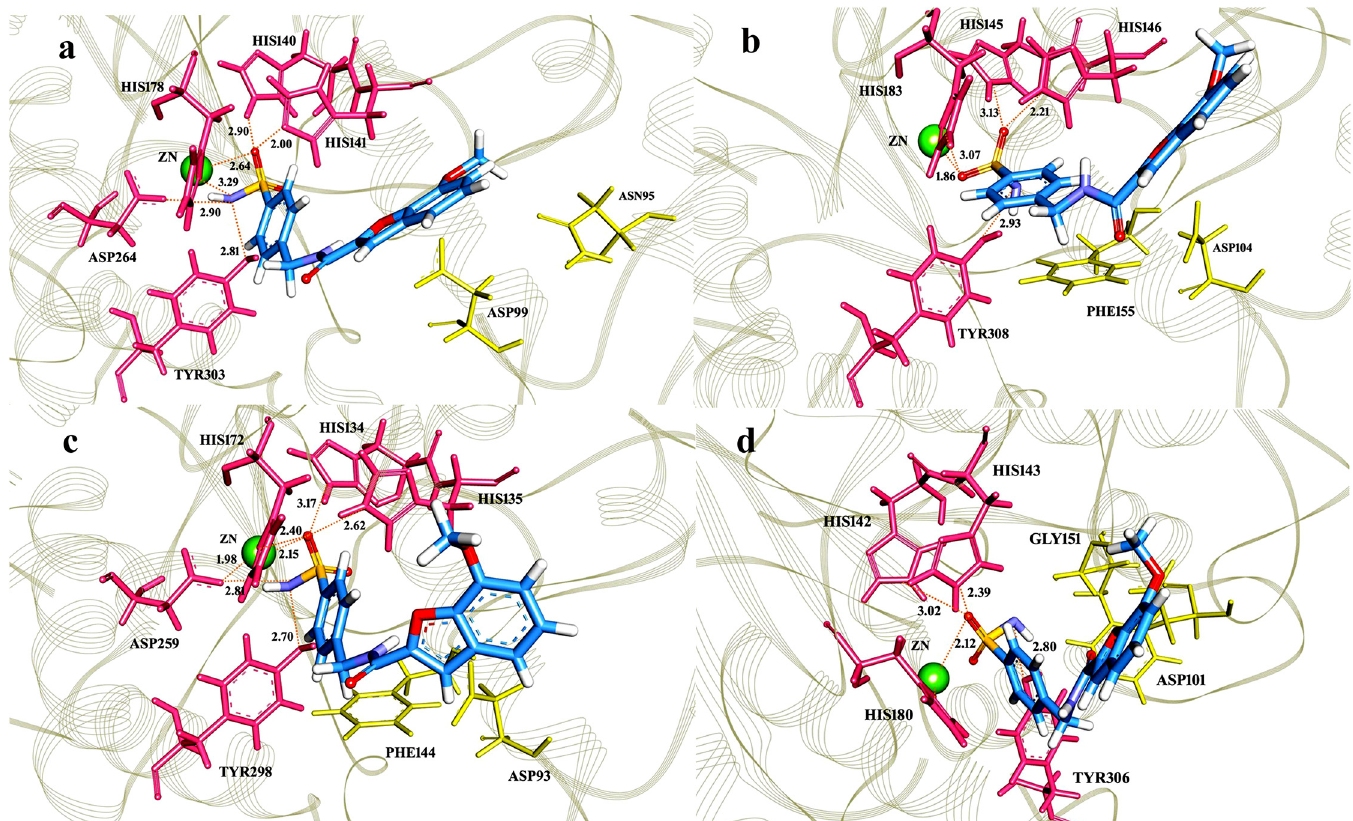
Fig 4. Binding pattern of compound C8 with class 1 HDACs. C8 (7-methoxy-N-((4-sulfamoylphenyl)methyl)-1-benzofuran-2-carboxamide) was shown in blue, whereas hydrogen bonding and hydrophobic residues were shown in pink and yellow, respectively. (a) Hit C8 forms hydrogen bonds with HIS140, HIS148, HIS178, ASP264 and TYR303 of HDAC1; (b) HIS145, HIS146, HIS183 and TYR308 of HDAC2; (c) HIS134, HIS135, HIS172, ASP259 and (d) TYR298 of HDAC3 and HIS142, HIS143, HIS180 and TYR306 of HDAC8. C8 bonding with Zn+2 is shown in green color with an average distance of 2 Å . Hydrophobic residues involved in interaction are (a) ASP99, GLY149, PHE150 and GLY301 in HDAC1; (b) PHE155, PHE210, ASP269 and GLY306 in HDAC2; (c) ASP93, PHE144, ASP170, PHE209 and GLY296 in HDAC3 and (d) PHE152, PHE208, MET274 and GLY304 in